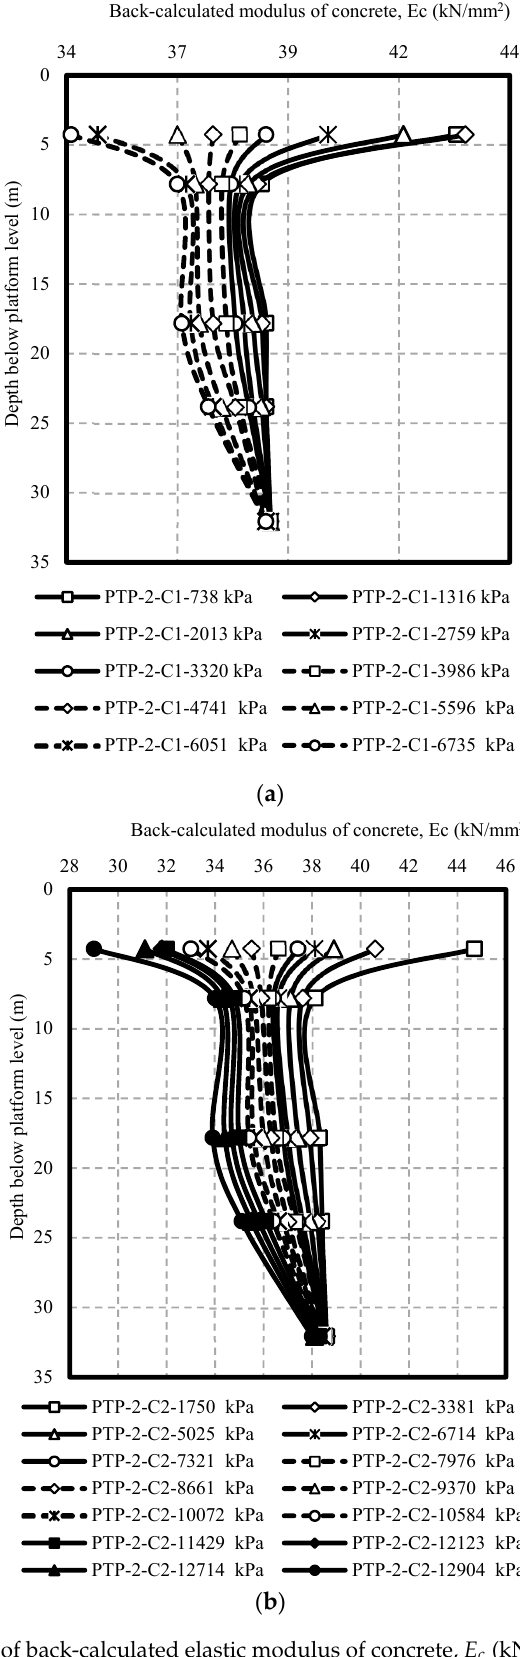
Figure 16. Distribution of back-calculated elastic modulus of concrete, E c (kN/mm 2 ) for BP# 2; ( a ) 1st cycle and ( b ) 2nd cycle.